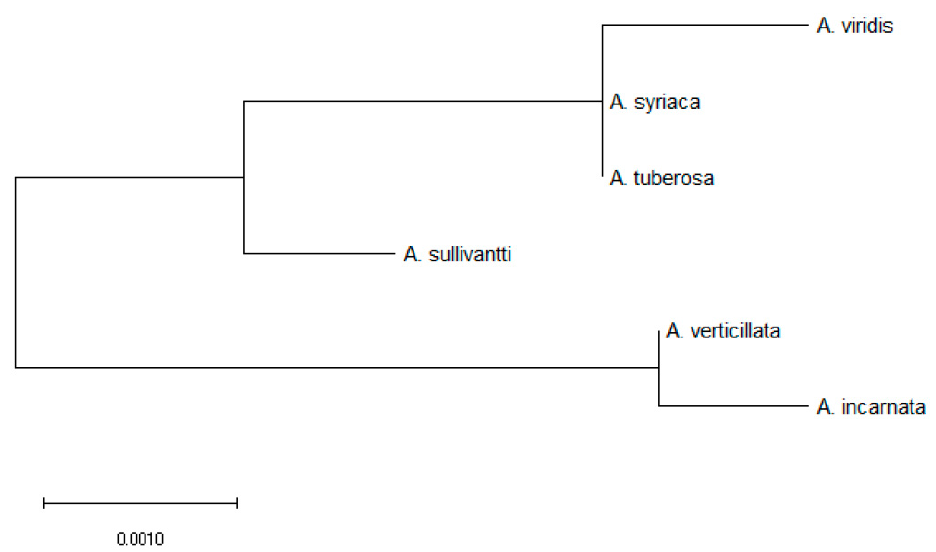
Figure 5. Provided here is a maximum likelihood tree for 6 the Asclepias species. This tree was constructed using highest log likelihood ( − 1398.00) for the rbcL amino acid sequence ( rbcL is a gene involved in CO2 fixation). According to this tree, fibrous root species, A. verticillata and A. incarnata , are distant from the 4 tap-root species.